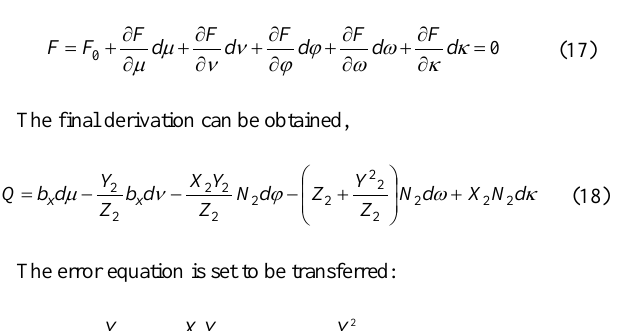
, , X Y Z is the coordinate of corresponding 2 2 2 image points in the right image in the photogrammetric coordinate system, b is the X axis component of the baseline x b , N is the projection coefficient of the right image, and Q is 2 the parallax. ,  are the low frequency detection error value. points and adjustment solution to carry out error